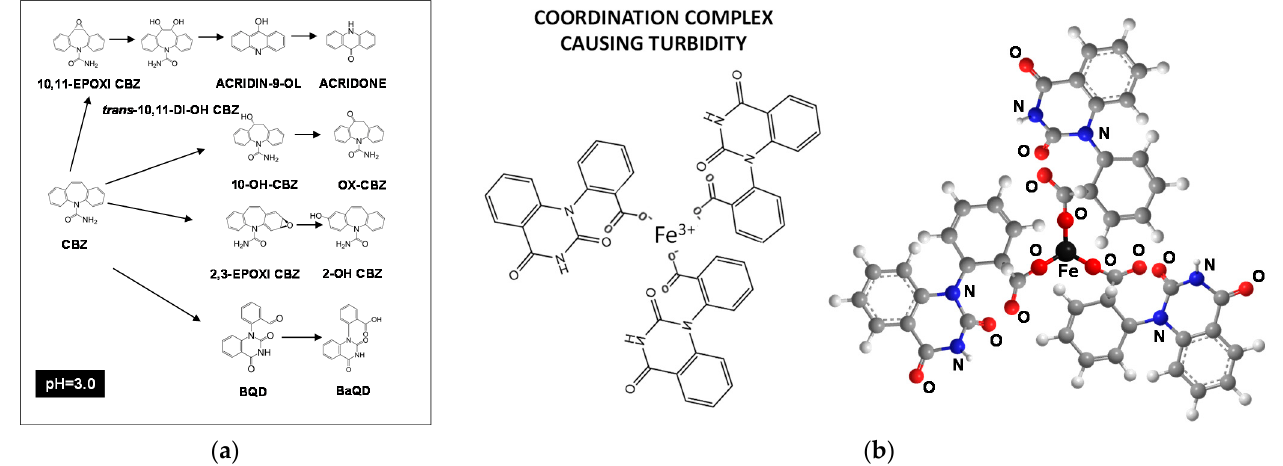
Figure 5. ( a ) Equilibrium-species in carbamazepine aqueous solutions oxidized by photo-Fenton treatment operating at pH = 3.0. ( b ) Molecular structure in 2D and 3D of possible coordination iron complex BaQD-Fe(III) causing turbidity in water. Experimental conditions: (CBZ) = 50.0 mg/L; pH = 3.0; (H 2 O 2 ) = 2.0 mM; (Fe) = 10.0 mg/L; (UV) = 150 W; T = 40 °C.